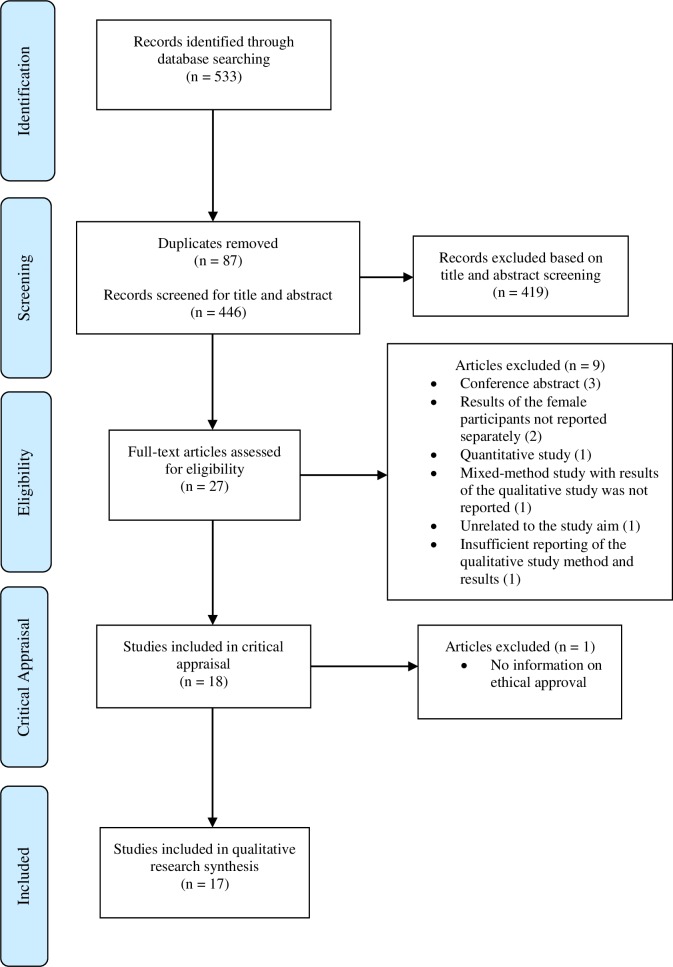
PRISMA flow diagram.